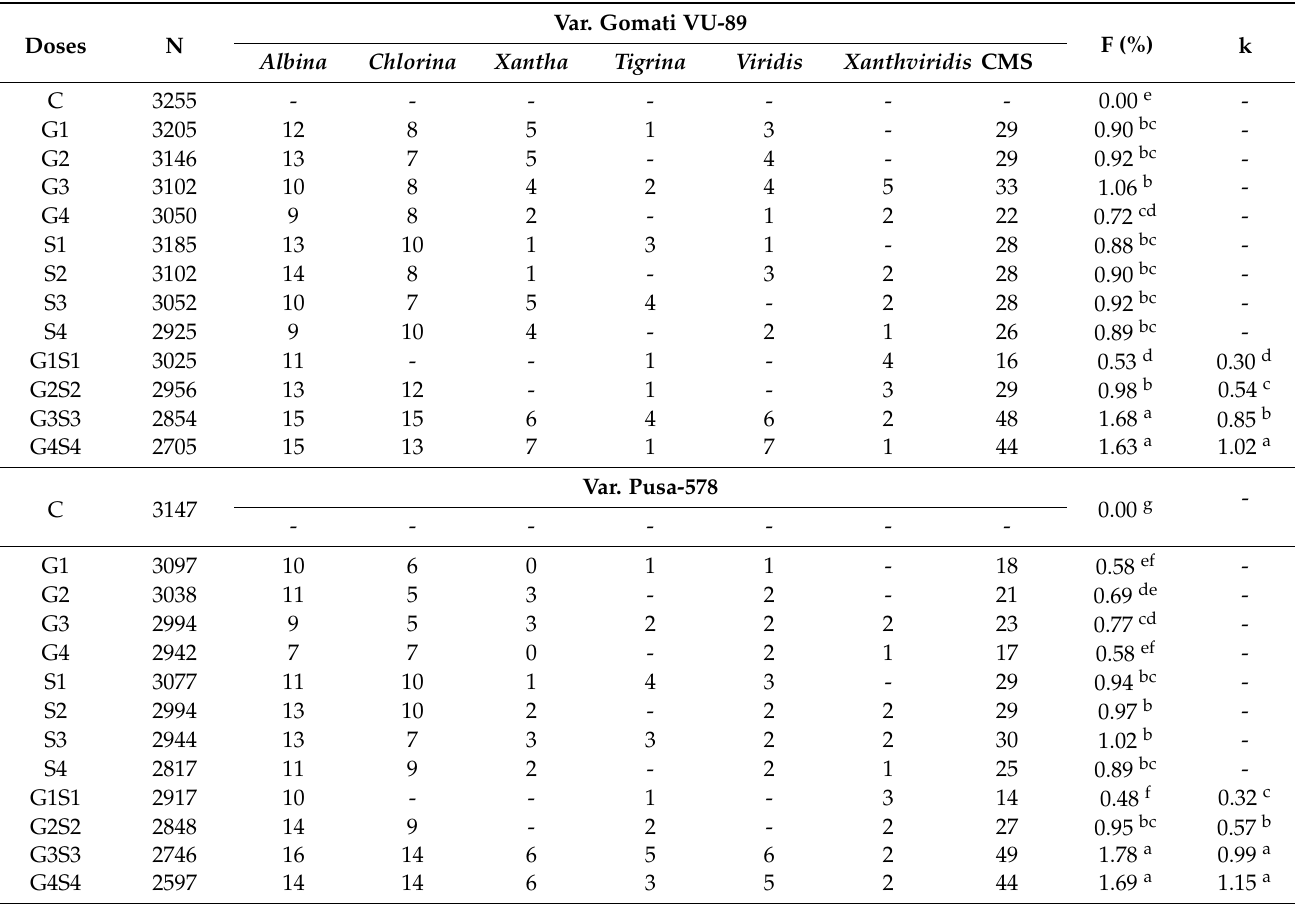
Table 2. Frequency and spectrum of chlorophyll mutants induced in different doses of γ rays and SA in cowpea varieties Gomati V-89 and